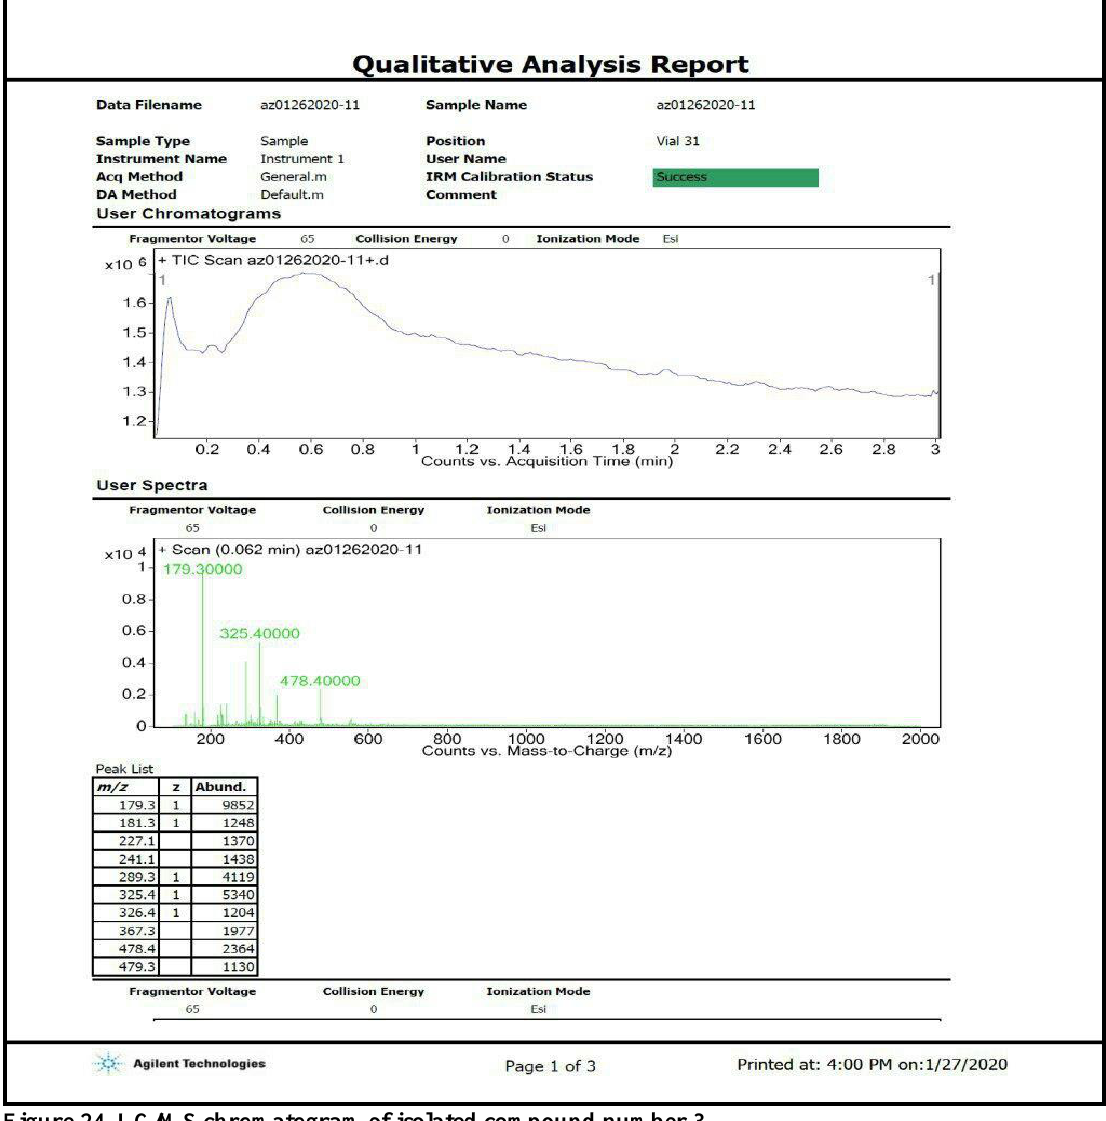
Figure 24. LC/MS chromatogram of isolated compound number 3. Molecular ion peak at m/z 181 that correspond to the isotope of a molecular formula of C9H8O4 (3,4-